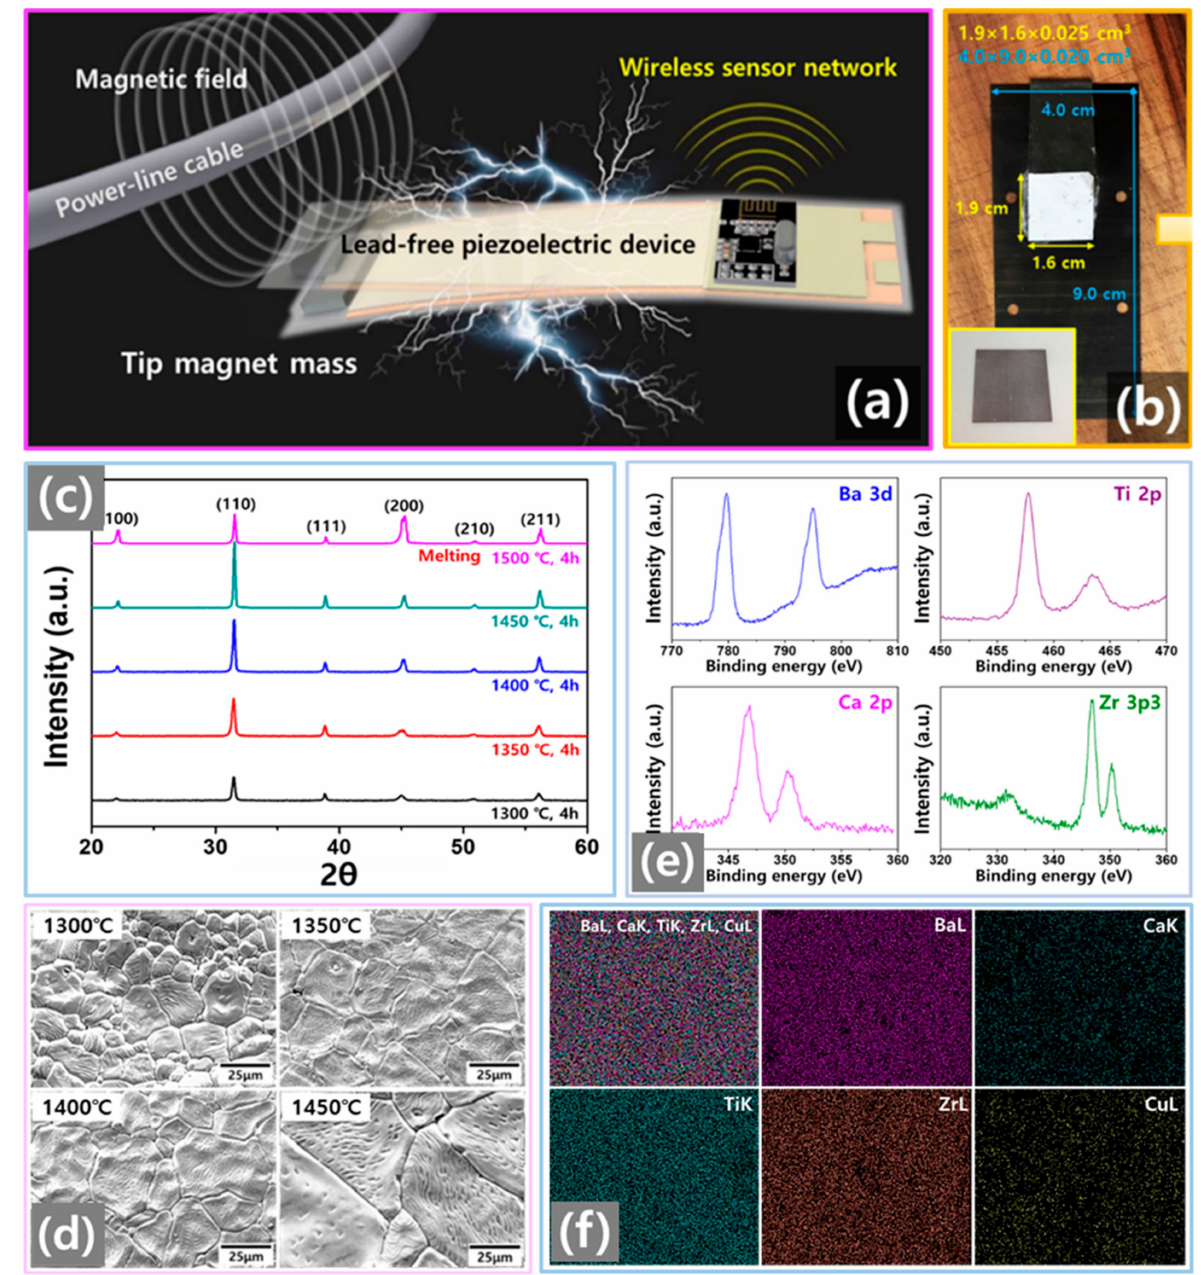
Figure 1. ( a ) Schematic of magnetic field energy harvesting using a lead-free piezoelectric device for a wireless sensor network. ( b ) Photograph of the lead-free piezoelectric energy harvester (LPEH) device, with the inset showing the piezoelectric film of BCTZC 0.3 sintered at 1450 ◦ C. ( c ) XRD graphs of BCTZC 0.3 ceramics sintered at various temperatures. ( d ) Surface field emission-scanning electron microscope (FE-SEM) images of the BCTZC 0.3 ceramics sintered at different temperatures. ( e ) X-ray photoelectron spectroscopy (XPS) component analysis graphs of the BCTZC 0.3 ceramic sintered at 1450 ◦ C. ( f ) Energy dispersive spectra (EDS) mapping analysis of the BCTZC 0.3